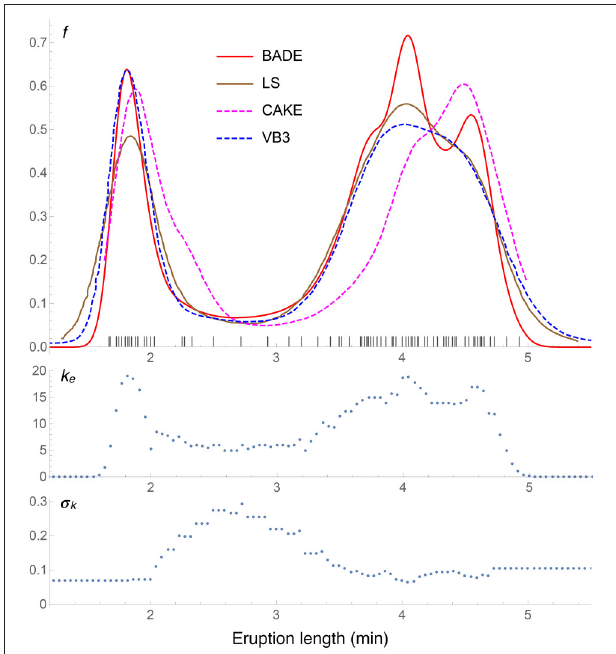
FIGURE 7 | Density estimates for the suicide data set, comparing our method (BADE) with LS (Brewer, 2000) and CAKE (Ganti and Gray, 2011 ). The second and third rows show, respectively, the optimal effective number of nearest neighbors, and the standard deviation of the set of the k nearest neighbors, at each point of a regular grid of size 100. The marks on the x axis indicate the sample